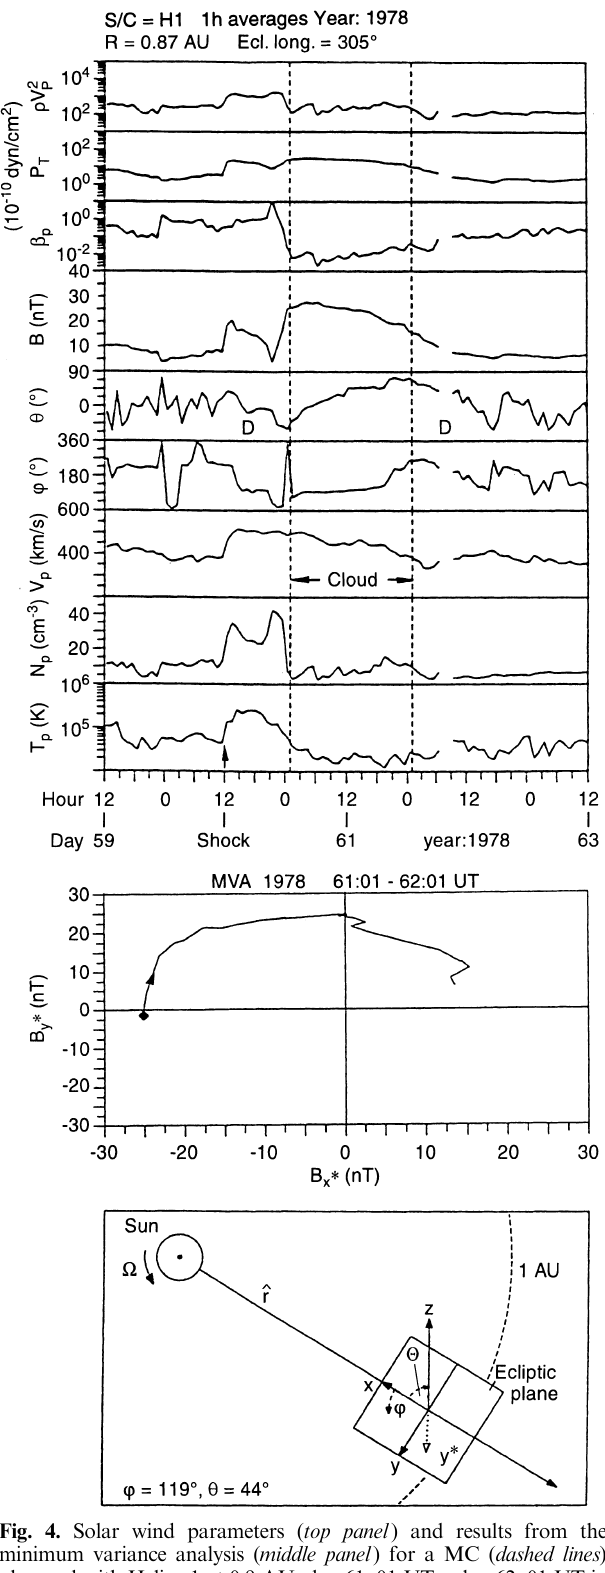
Fig. 4. Solar wind parameters ( top panel ) and results from the minimum variance analysis ( middle panel ) for a MC ( dashed lines ) observed with Helios 1 at 0.9 AU, day 61, 01 UT – day 62, 01 UT in 1978. The MC was associated with a shock on day 60, 12 UT. The draping of the IMF in the cloud’s sheath region and behind the cloud’s rear portion is labelled ( D ). The calculated orientation of the cloud’s axis, sketched in the bottom panel , was (cid:117) (cid:136) 119 (cid:14) , (cid:104) (cid:136) (cid:135) 44 (cid:14) : The direction of minimum variance was (cid:117) (cid:136) 189 (cid:14) , (cid:104) (cid:136) (cid:255) 20